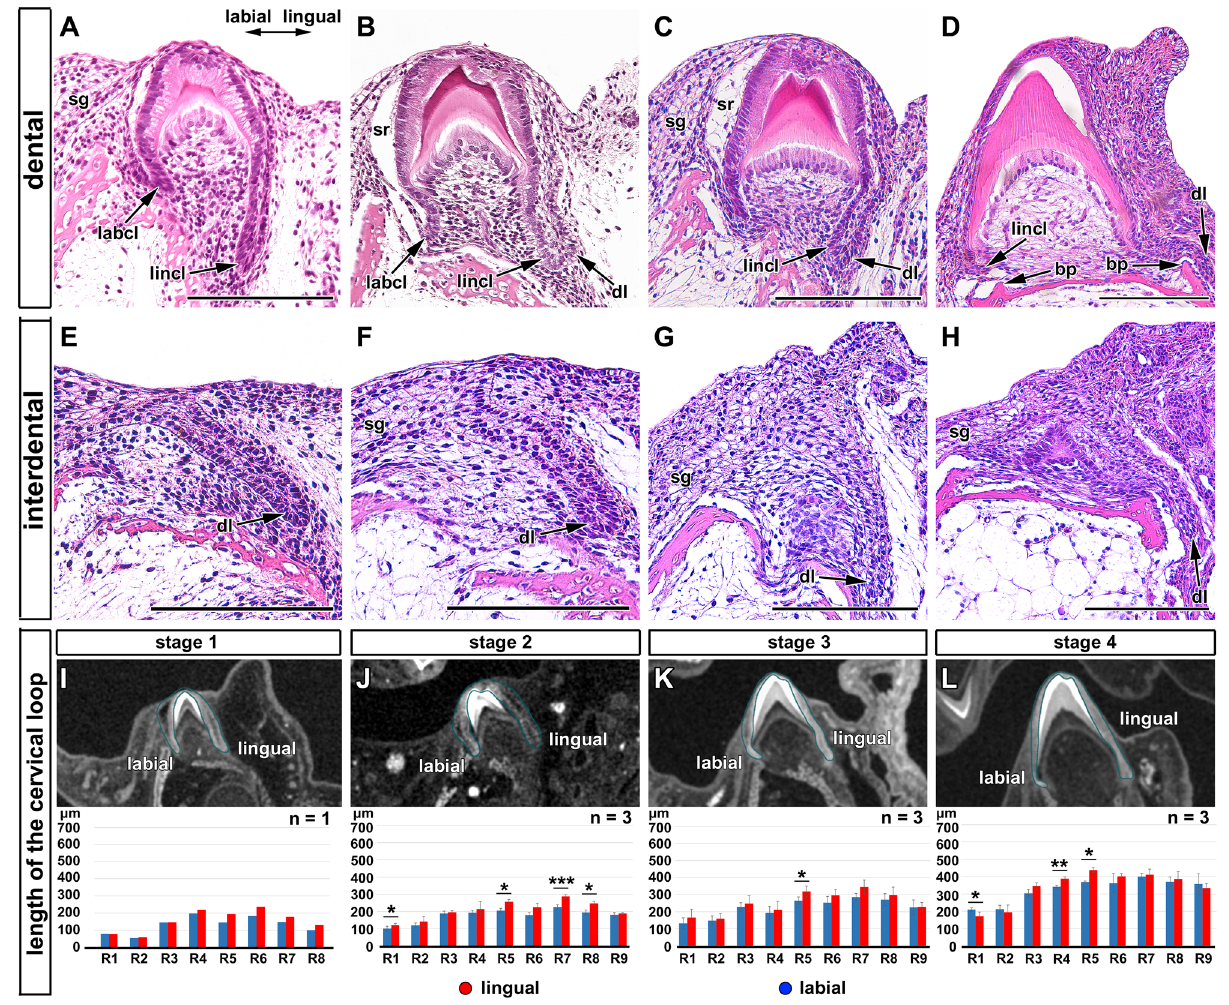
Figure 4. Labio-lingual asymmetry of enamel organ during mineralization stages in chameleon embryos. ( A – D ) Transversal histological sections through the central cusp of the tooth from early ( A , B ) to late ( C , D ) mineralization stage. Dental areas exhibiting distinct differences in the lingual and labial part of the cervical loop (arrows). ( E – H ) Detailed view on the interdental areas with dental lamina protruding lingually at early ( E , F ) and late ( G , H ) mineralization stages. bp bone pedicle, dl dental lamina, labcl labial cervical loop, lincl lingual cervical loop, sg salivary glands, sr stellate reticulum. Scale bars ( A – H ) = 50 µm. ( I – L ) Analysis of the length of the labial (blue) and lingual (red) parts of cervical loop revealed differences between the size of labial and lingual part of cervical loop at early ( I , J ) and late ( K , L ) mineralization stages. The lengths of labial and lingual part were not consistent along the jaw. The lingual part of the loop remained slightly longer throughout all analysed stages. R1 to R9 refer to the individual position of teeth on the right side of the jaw in order from the most rostral teeth (R1) to the tooth in the caudal area (R9). n = number of analysed mandibles for each stage. Pair t-test was used to analyze statistical significance of differences between labial and lingual part of the tooth. *p < 0.05, ** p < 0.01, *** p <